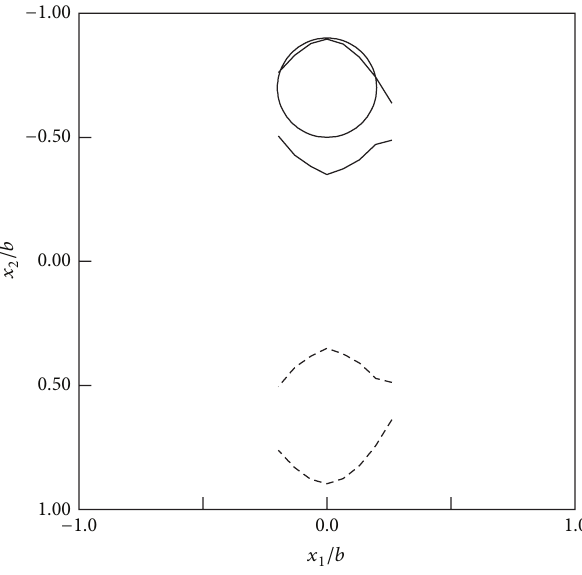
Figure 7: Reconstructed cavity with 𝑅 1 = 0.05𝑏 , 𝑅 2 = 0.2𝑏 , and ̃𝑥 2 = −0.5𝑏